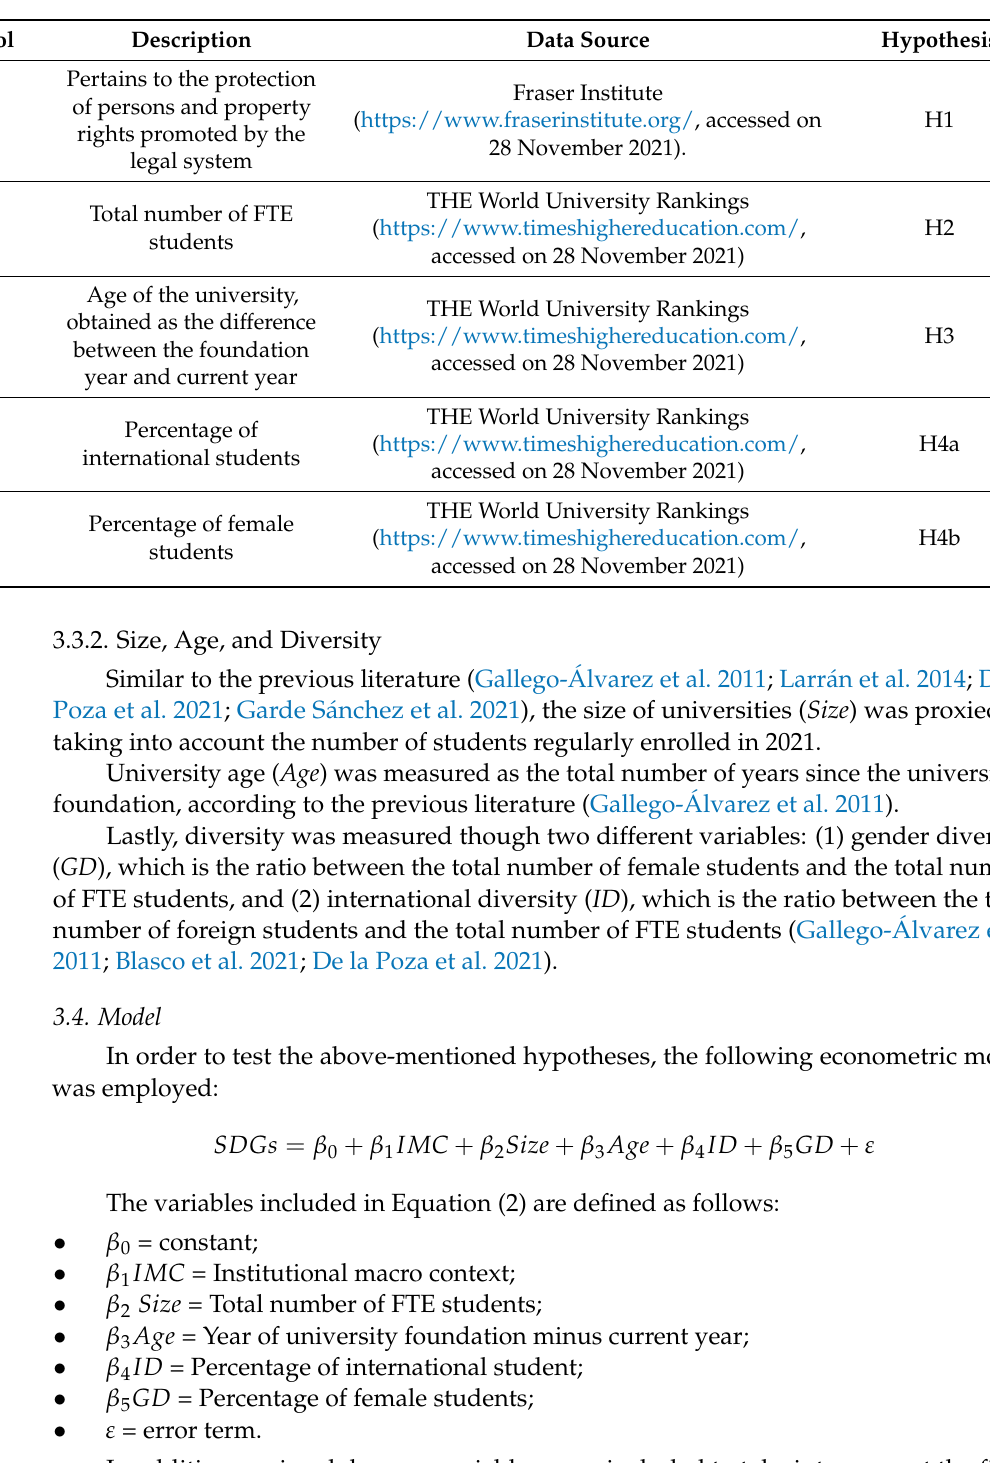
Table 4. Independent variable